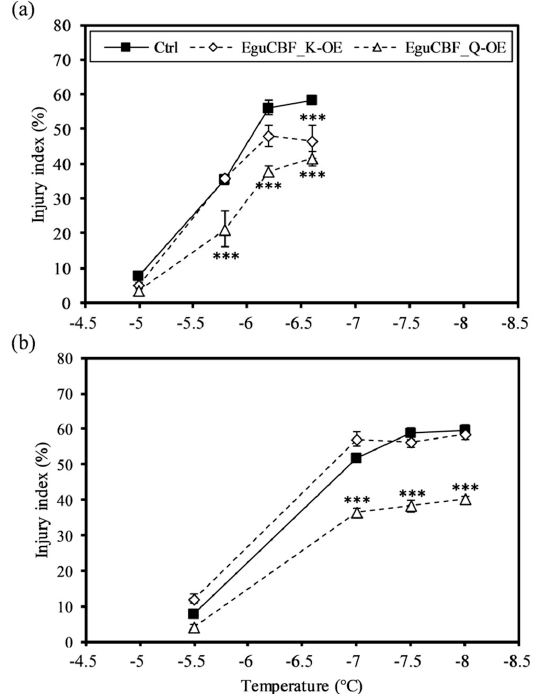
Figure 1. Frost tolerance of CRT-repeat binding factor overexpressing (CBF -OE) transgenic lines. Frost tolerance was assessed using the ion leakage method on leaf discs ( a ) and stem segments ( b ) of 6-month-old transgenic plants overexpressing the gene EguCBF_K (EguCBF_K-OE) or EguCBF_Q (EguCBF_Q-OE) and control plants transformed with an empty vector. Results are means ± SD of three biological replicates. ANOVA and Tukey HSD test p < 0.05 (***) were used to highlight statistical differences between transgenic lines and controls.